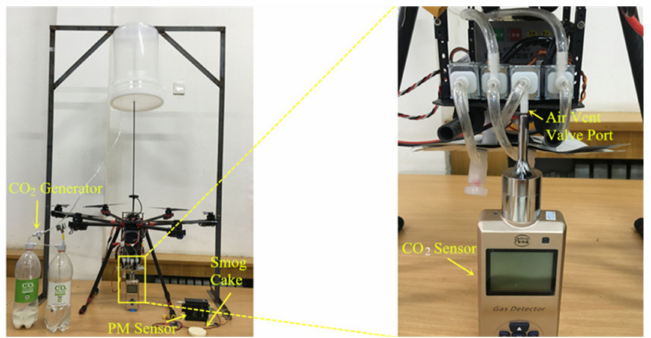
Figure 3. Experimental configuration to identify how long it takes to replace the original gas in unmanned aerial vehicle-based gas sampling system (UGSS) with gas from the target location using its pump to avoid the original gas being stored in air